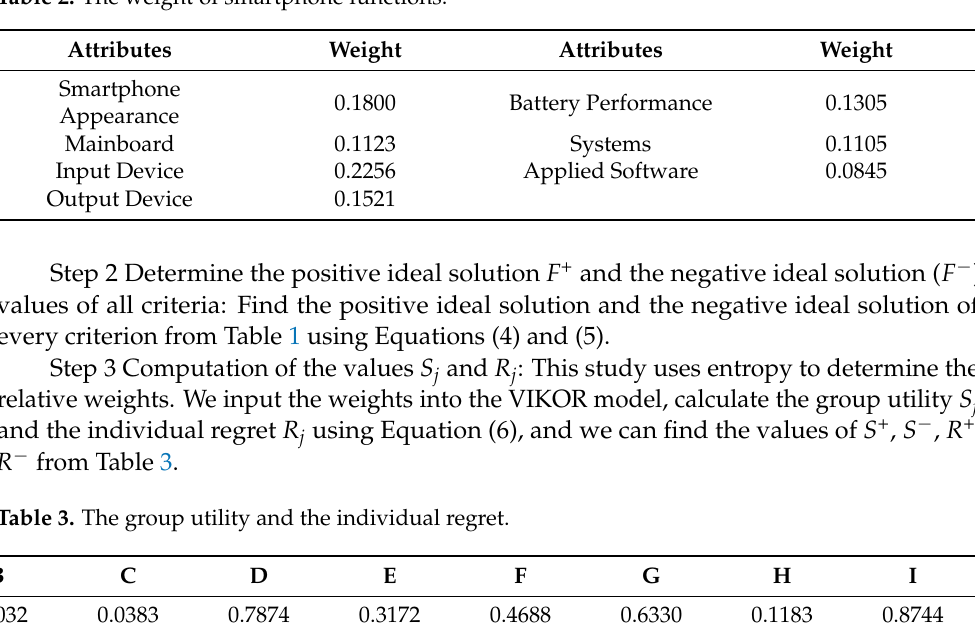
Table 2. The weight of smartphone functions.